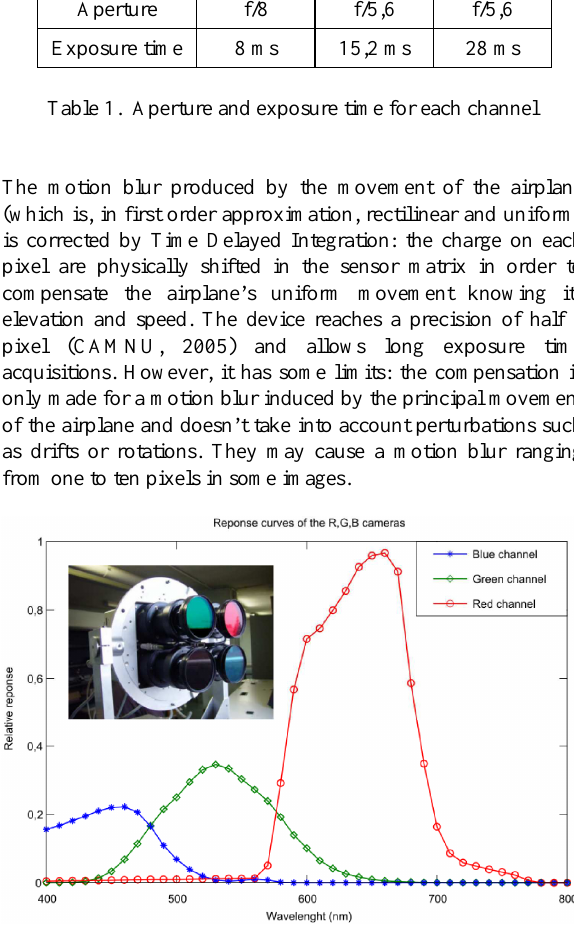
Figure 1. Cameras response for constant exposure and aperture (inset: 4 channels digital camera used in our